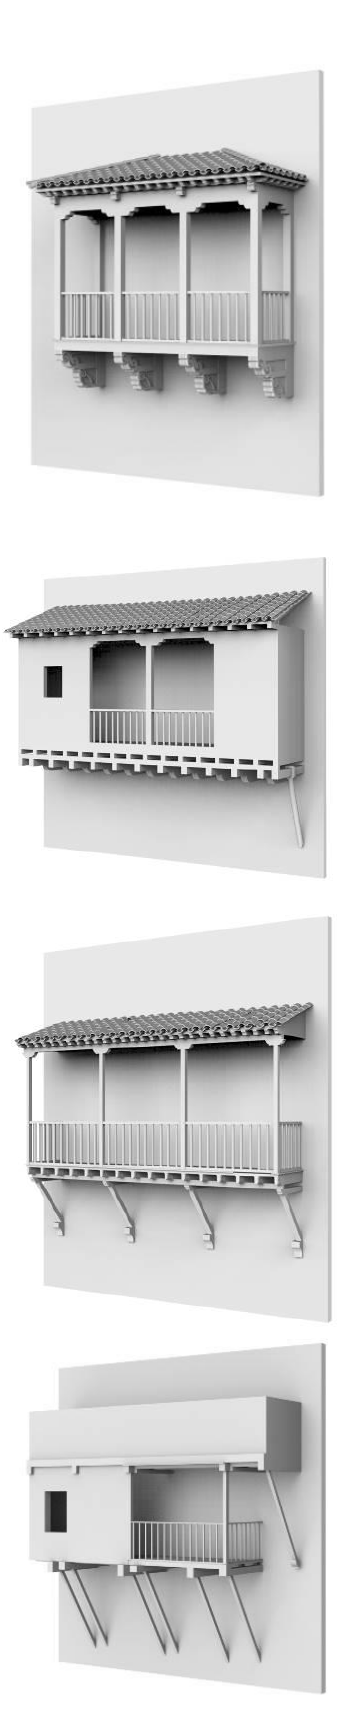
Figure 10. 3D study of different balcony